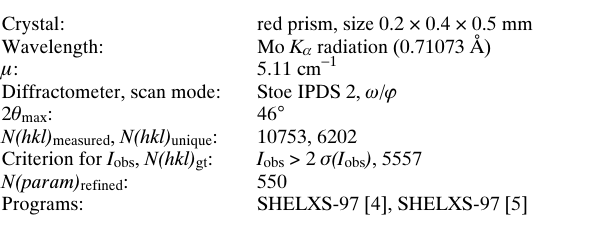
Table 1. Data collection and handling.